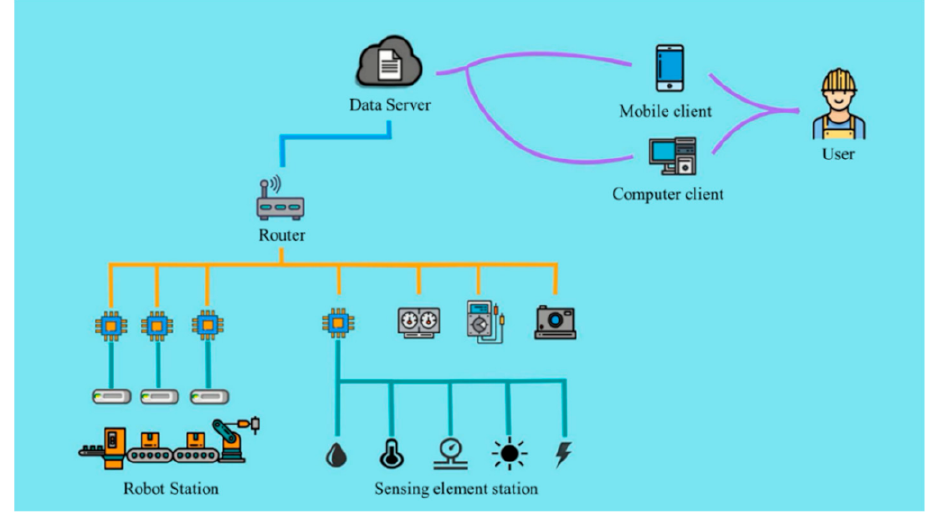
Figure 1. Smart production-line conceptual diagram.